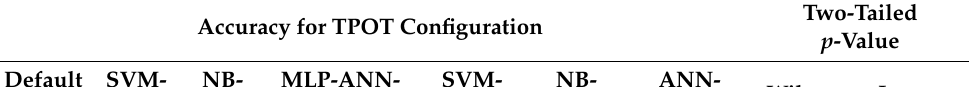
Table 3. Accuracy score for various TPOT and grid search method configuration. Accuracy for TPOT